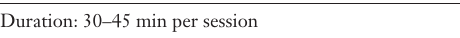
General guidelines for training patients with chronic conges- tive heart